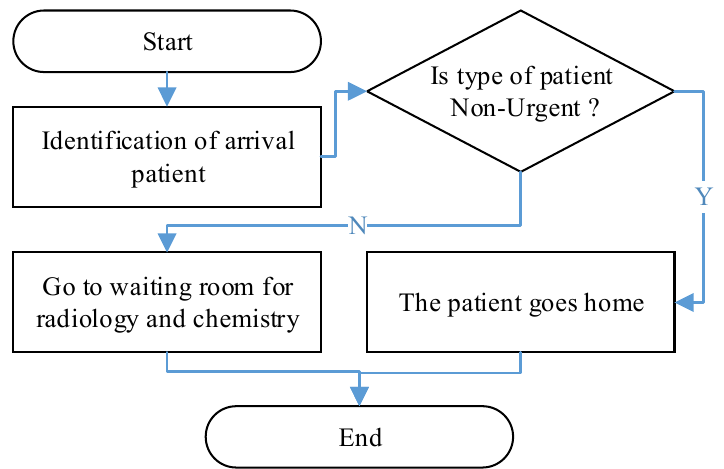
Figure 7. Layout and logic of patient movement shown through connectors.